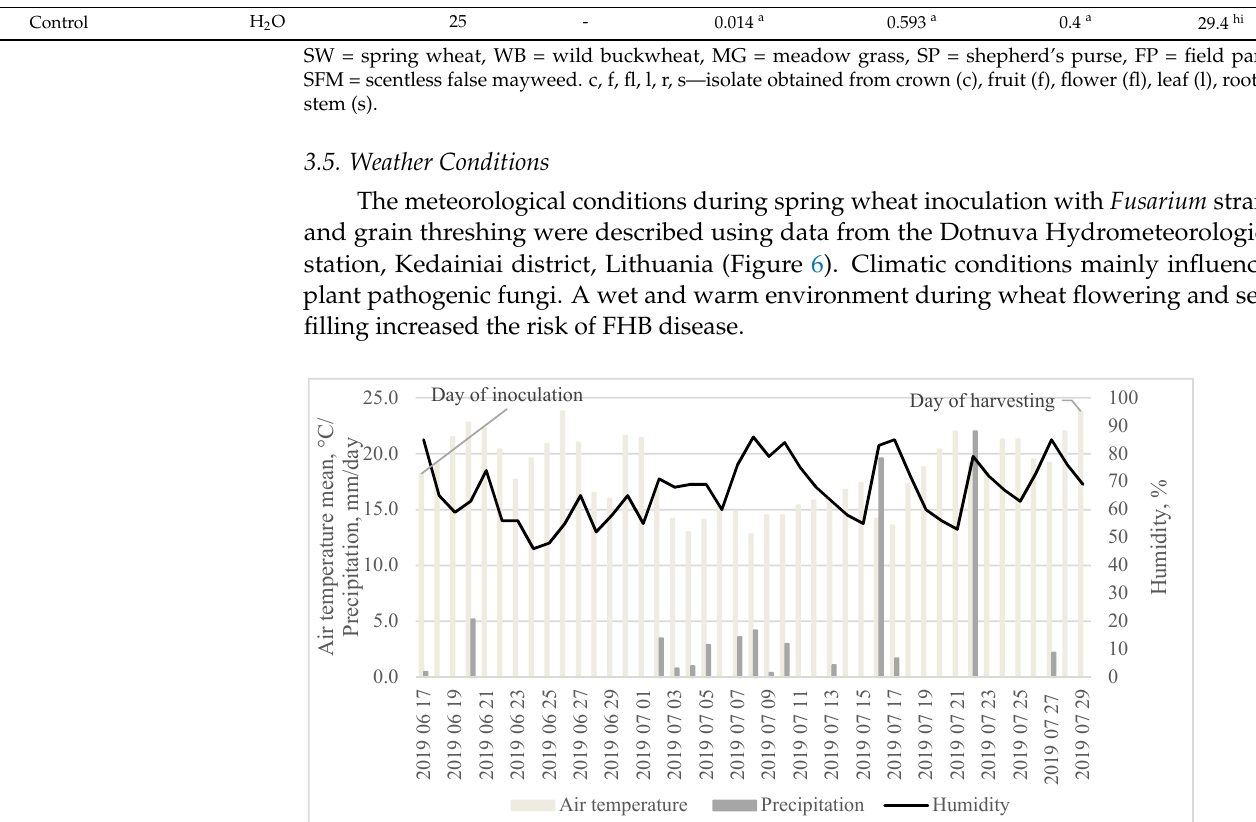
Figure 6. Meteorological observations after wheat inoculation day.